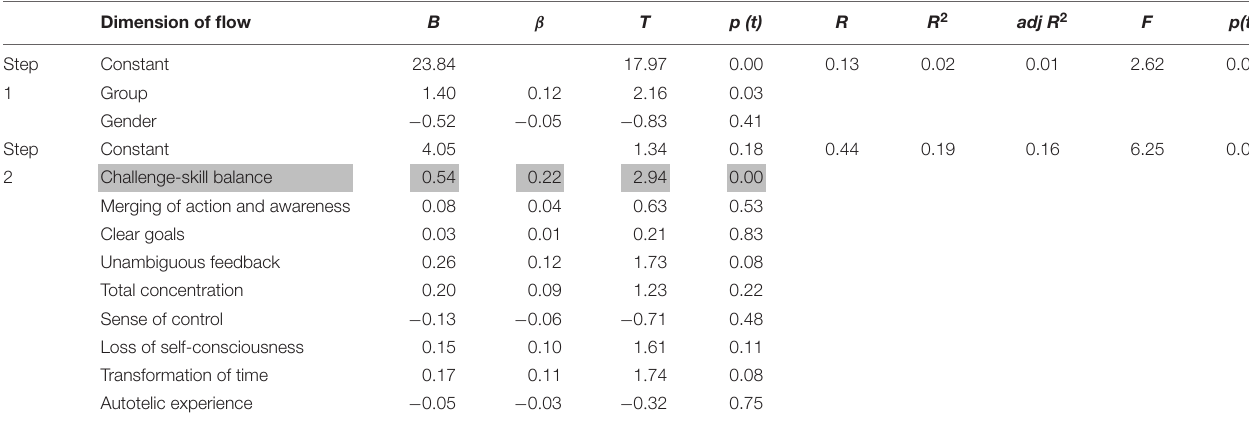
TABLE 7 | Prediction of satisfaction with life on the basis of flow disposition. Dimension of